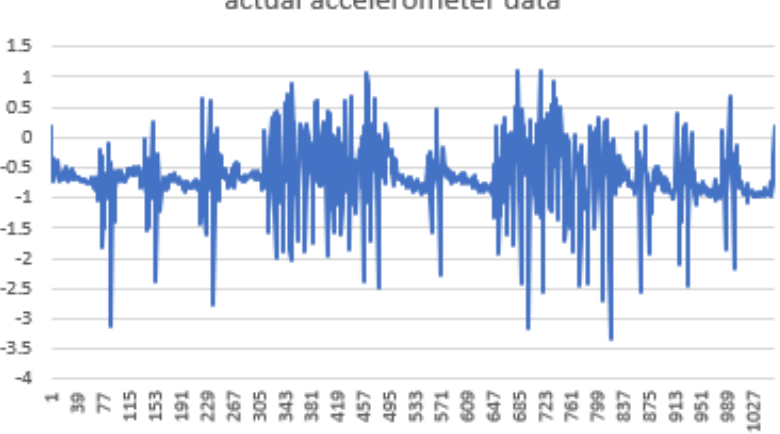
Figure 6. Acceleration sensor at point 1, showing data noise.